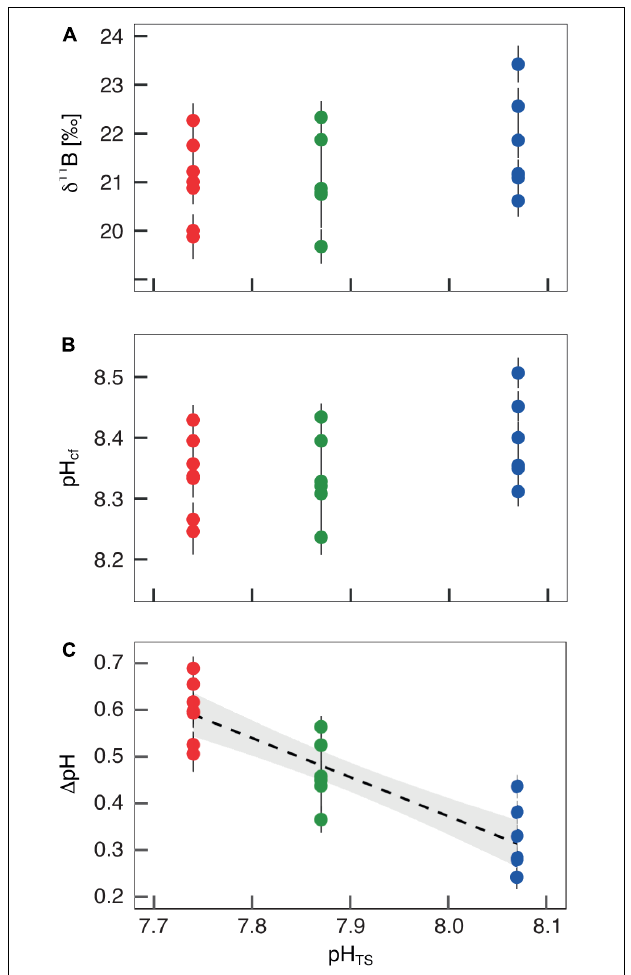
FIGURE 2 | Boron isotopic signature ( δ 11 B), δ 11 B-derived pH in the calcifying fluid (pH cf ) and pH up-regulation ( (cid:49) pH) in Balanophyllia europaea along the pH TS gradient at Panarea Island. (A) δ 11 B measured in corals collected at three different sites along a natural pH gradient (Site 1, average pH